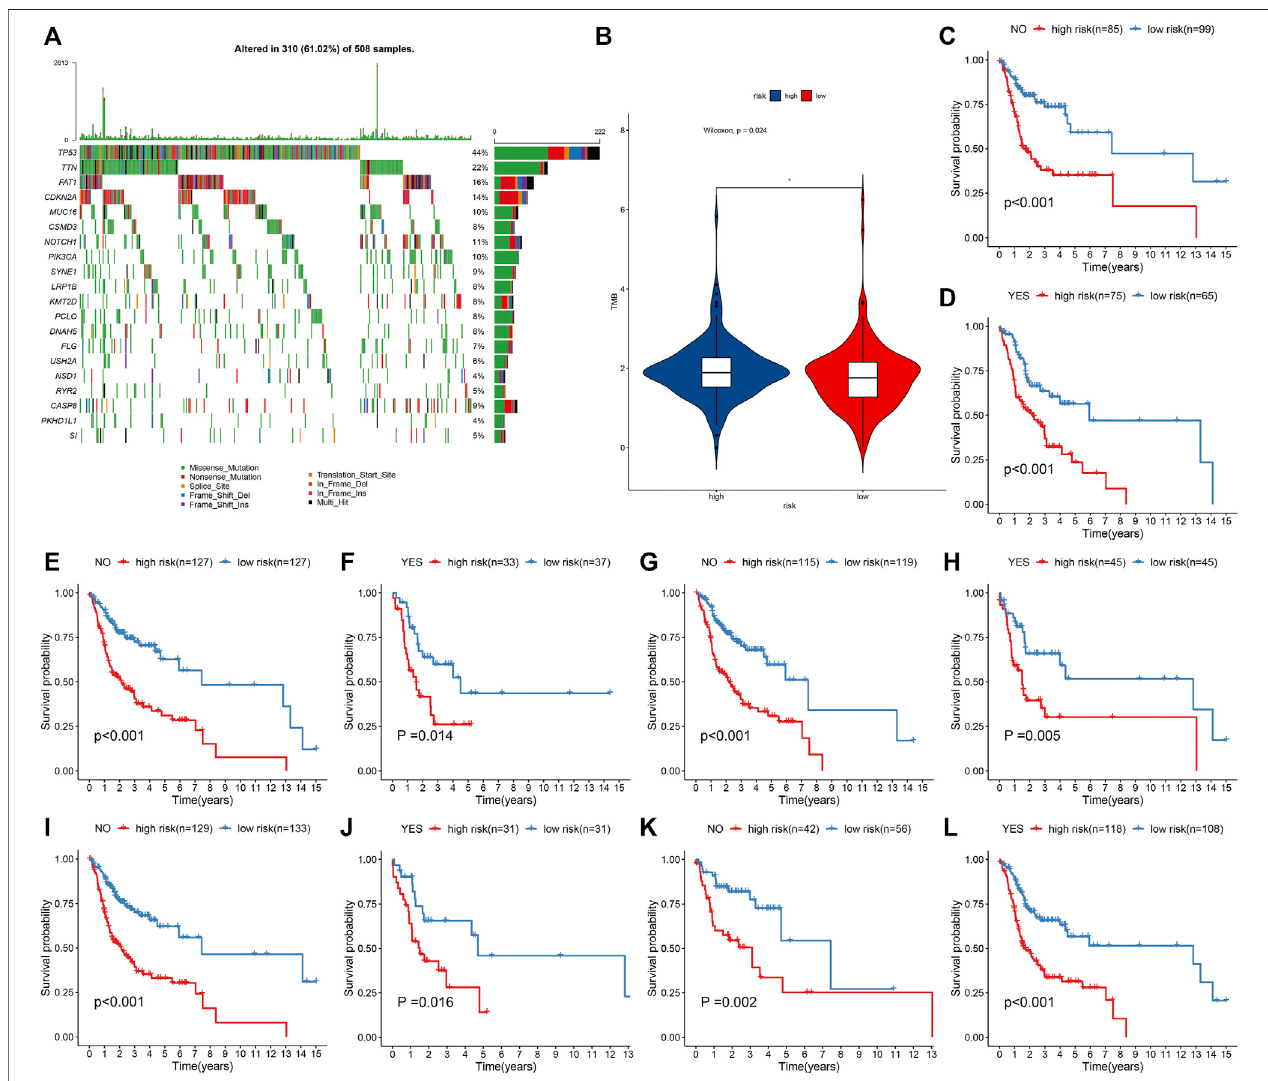
FIGURE 5 | IRS model is independent of genetic mutations in predicting prognosis of OSCC patients from the TCGA cohort. (A) Waterfall plots showing the mutation distributions of the fi rst 20 most frequently mutated genes. The upper panel showed the mutation frequency in each OSCC specimen. The central panel depicted the mutation types across OSCC patients. The bar plots on the right side showed the frequency and mutation types of genes. The bottom panel meant the legends for mutation types. (B) Comparison of TMB score in high- and low-risk groups. * p < 0.05. (C – L) K – M curves of OS between high- and low-risk patients in each subgroup, including mutated and nonmutated TTN, CDKN2A, FAT1, MUC16, and TP53.